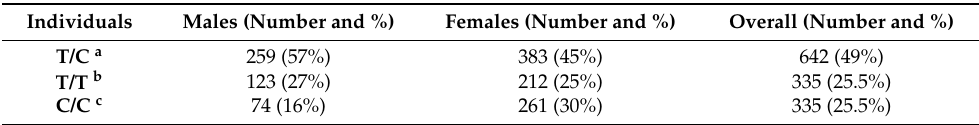
Table 2. Difference of genotype frequency between males ( n = 456) and females ( n = 856) of rs1800907 SNP of the human TCR β . The total number of individuals included was